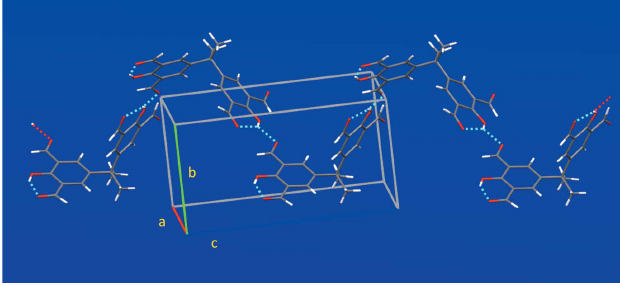
Figure 4 Hydrogen bonding of ( 2 ) showing both its intra- and intermolecular hydrogen bonds, depicted as blue dashed lines. Figure 2